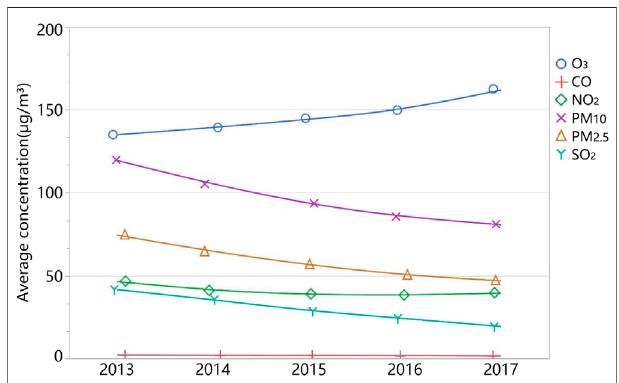
FIGURE 3 | Air pollutants in the pilot cities.